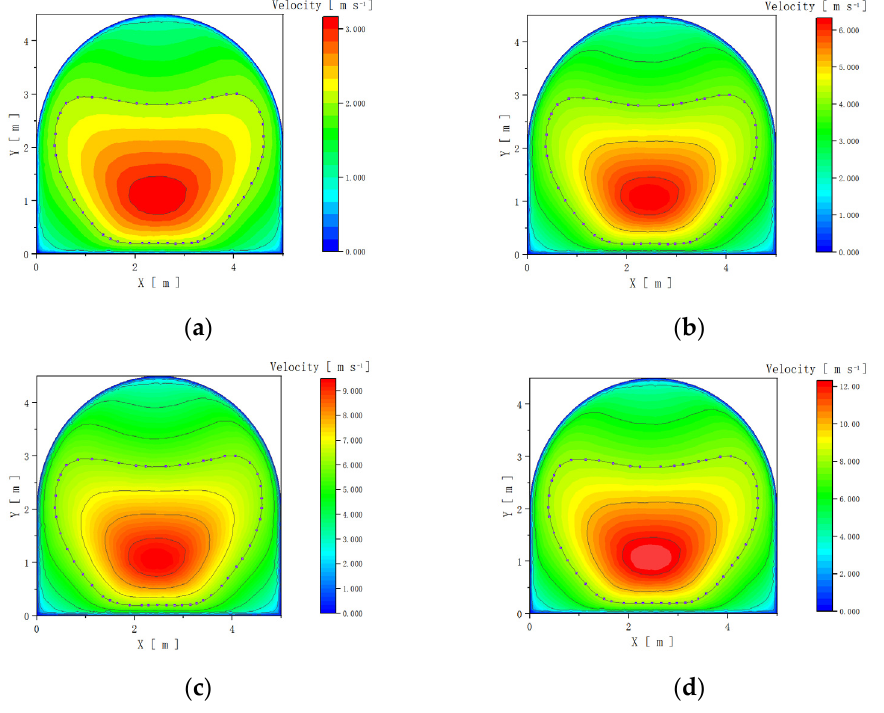
Figure 12. Contour lines of air speed 25 m behind the wide door. ( a ) 2 m/s; ( b ) 4 m/s; ( c ) 6